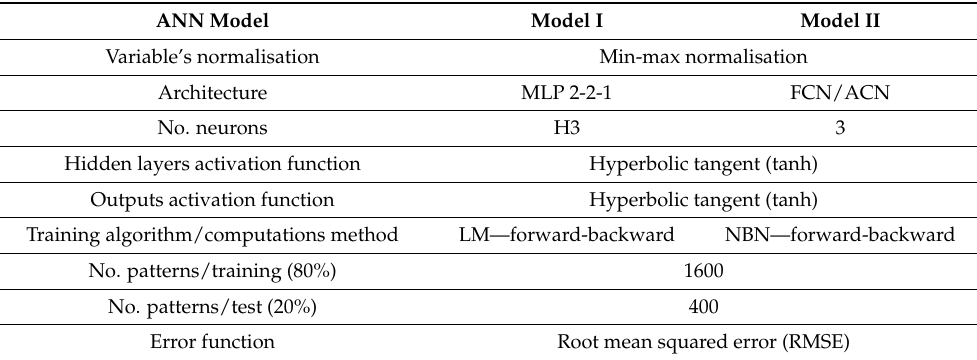
Table 3. Summary of the ANN models developed for the prediction of the generated power and gearbox efficiency.